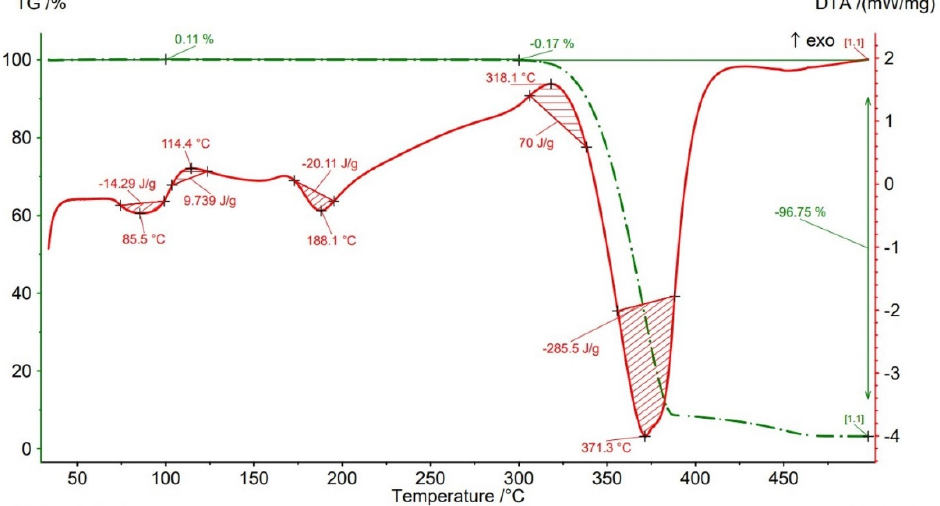
Figure 16. Thermogravimetric analysis curves for sample with 100% infill density.